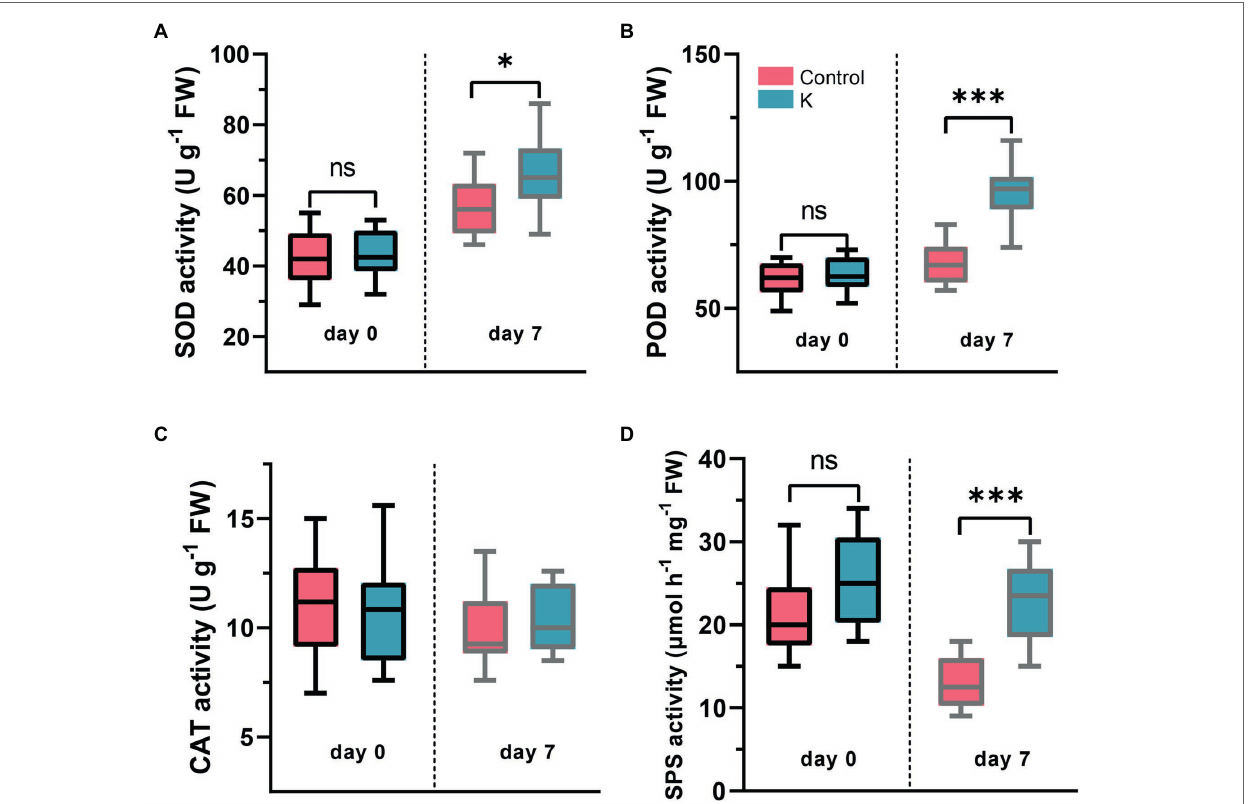
FIGURE 5 | Box plot showing changes of SOD (A) , POD (B) , CAT (C) , and SPS (D) activities in maize seedlings treated with Mucilaginibacter sp. K or not. The 14-day-old maize seedlings (day 0) were grown under salt stress (100 mM) for up to 7 days, and the 21-day-old seedlings were harvested for enzyme activity analysis ( * p < 0.05 and *** p < 0.001).